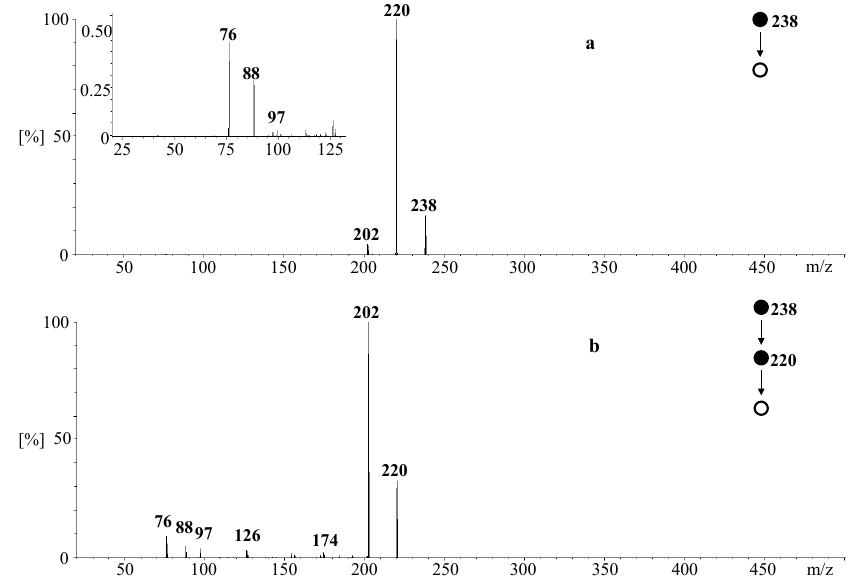
Figure 3. The ion trap MS 2 ( a ) and MS 3 ( b ) CID spectra of the L-glycine/D-glucose condensation product at m/z 238. The inset shows the diagnostic fragmentation peaks in the m/z 25–130 interval of MS 2 .